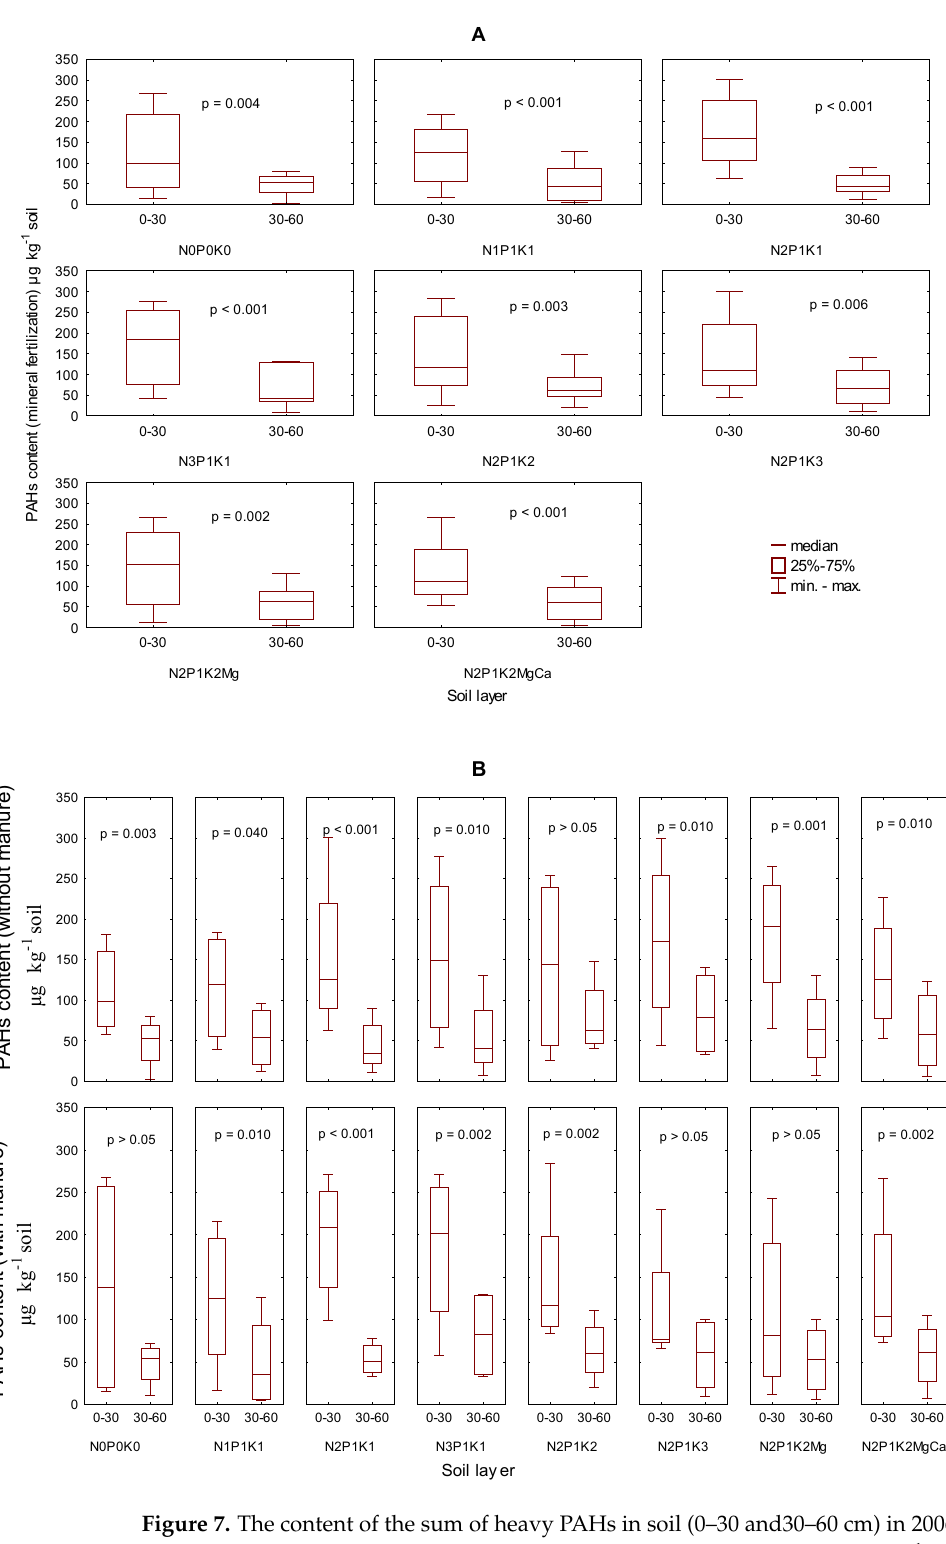
Figure 7. The content of the sum of heavy PAHs in soil (0–30 and30–60 cm) in 2006–2009 depending on the mineral fertilization ( A ) and manure-mineral fertilization ( B ) in µg kg − 1 .